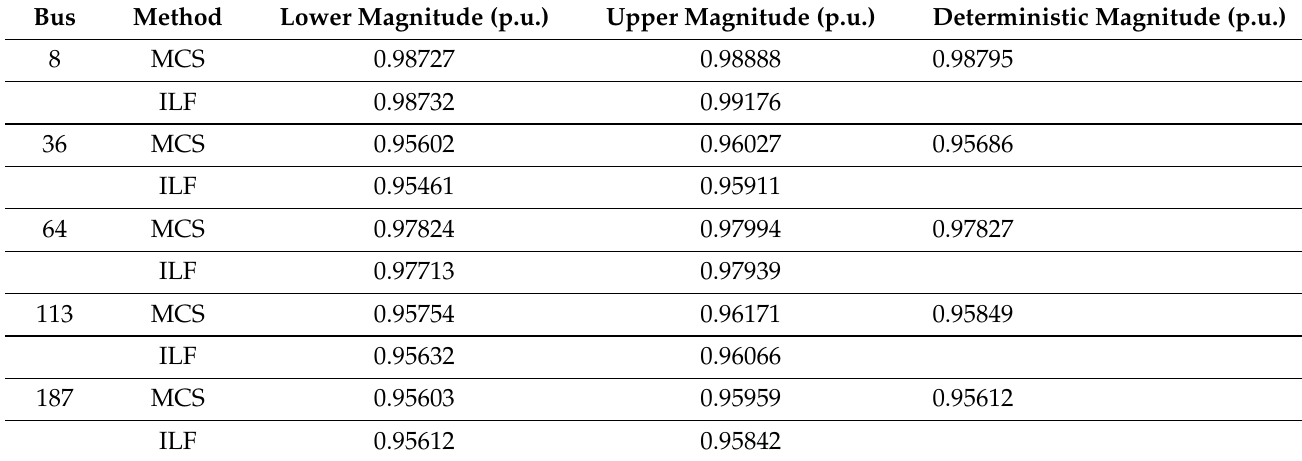
Table 6. Voltage Magnitude—192-bus Brazilian distribution